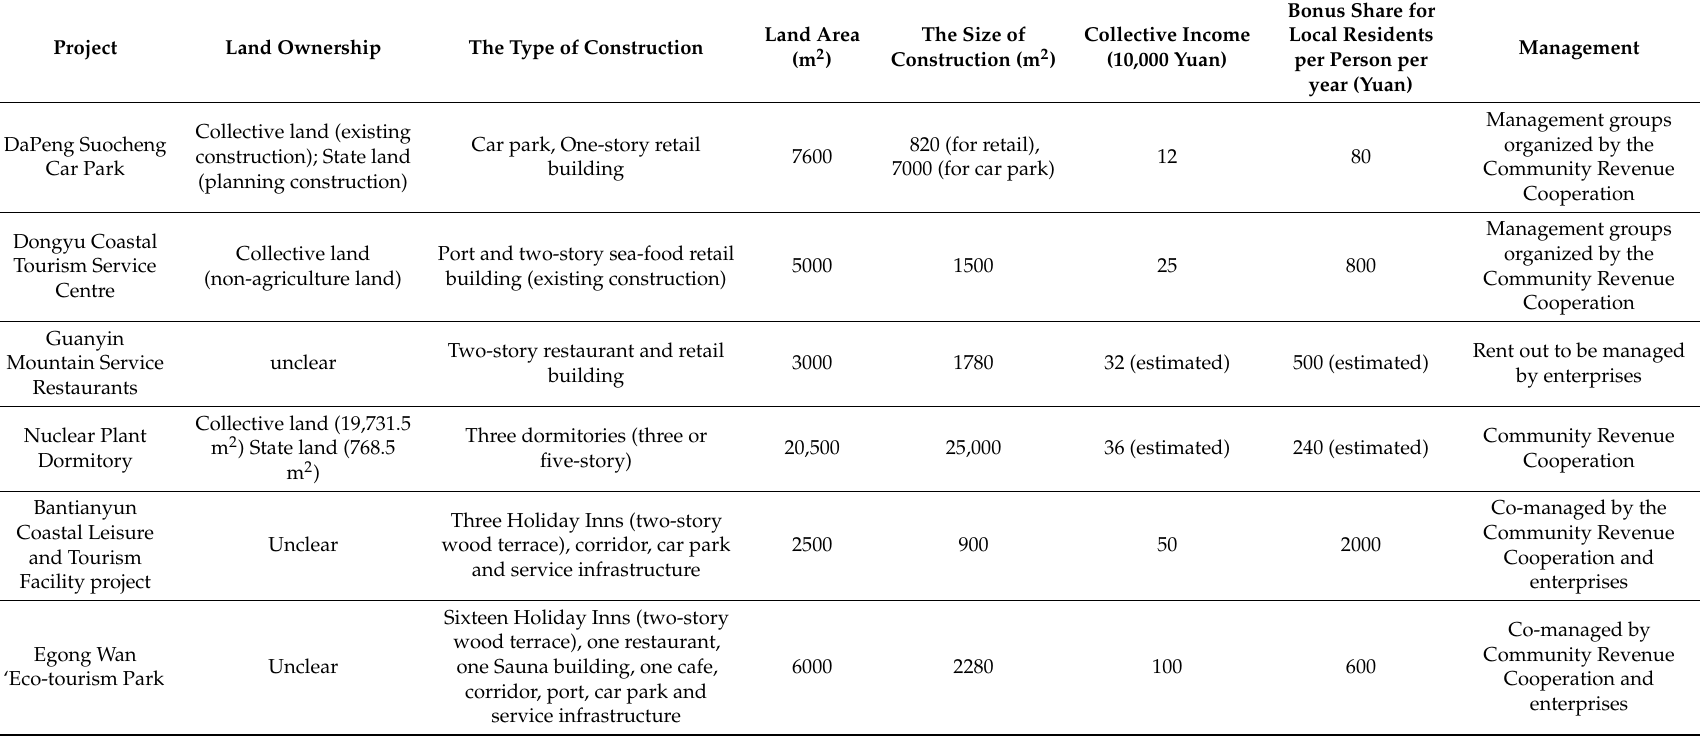
Table 3. Details of selected DPK projects. Source: Author’s compilation based on